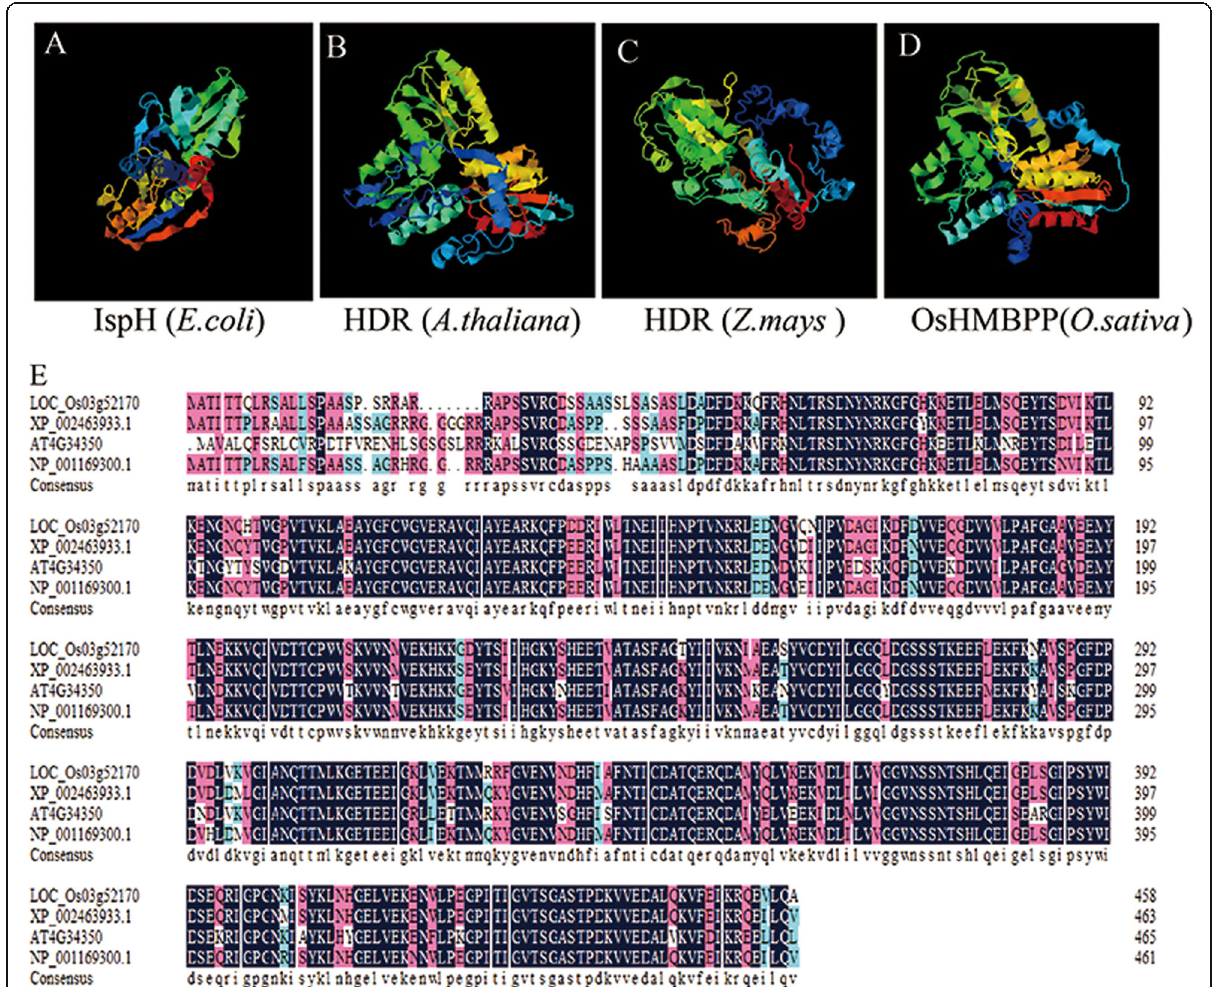
Fig. 4 Protein structure of OsHMBPP and sequence alignment of multiple amino acids from different organisms. a Structure prediction of the HMBPP reductase IspH ( Escherichia coli ), HDR ( Arabidopsis ), HDR( Zea mays ) and OsHMBPP ( Oryza sativa ) by I-TASSER algorithm. b Amino acid sequence alignment of the 3 types of OsHMBPP homologs. Amino acids that were fully or partially conserved are shaded blue and green, respectively